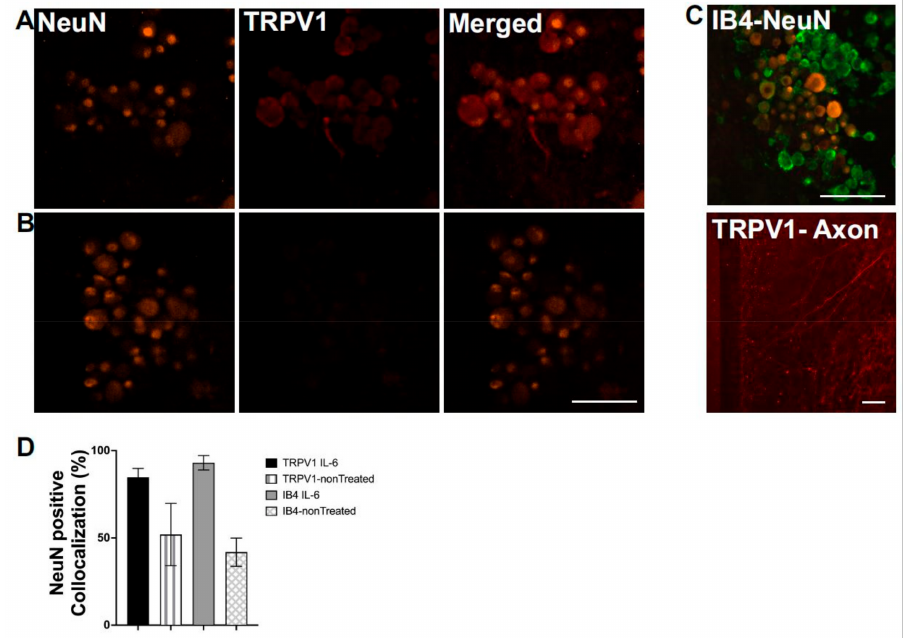
Figure 2. Immunocytochemistry (ICC) profile of cultures in microfluidic devices at day in vitro